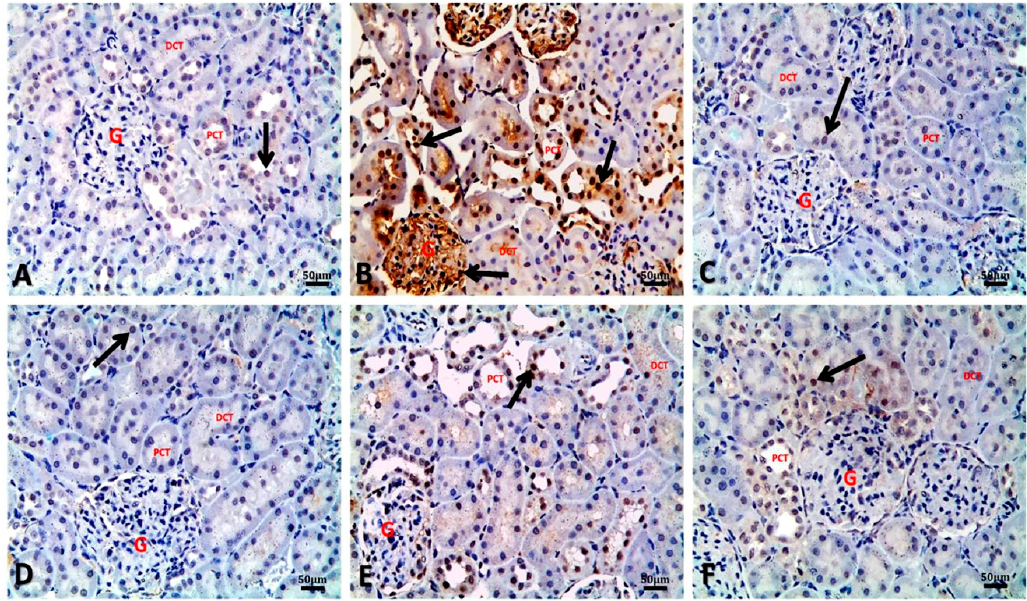
Figure 6. Representative photomicrographs of immuno-histochemical localization of caspase-3 in kidney sections of different groups (caspase-3 IHC, bar = 50 µm). ( A ) Control group showing slight nuclear immune-staining of caspase-3 in the renal tubular cells. ( B ) BM group showing marked dark immune-staining of caspase-3 in both glomerular and renal tubular cells. ( C ) AO/0.5 and ( D ) AO/1 showing slight nuclear immune-staining of caspase-3 as control group. ( E ) BM + AO/0.5 showing mild immune-staining of caspase-3 within some renal tubules. ( F ) BM + AO/1 showing mild immune-staining of caspase-3 within the renal tubular cells.